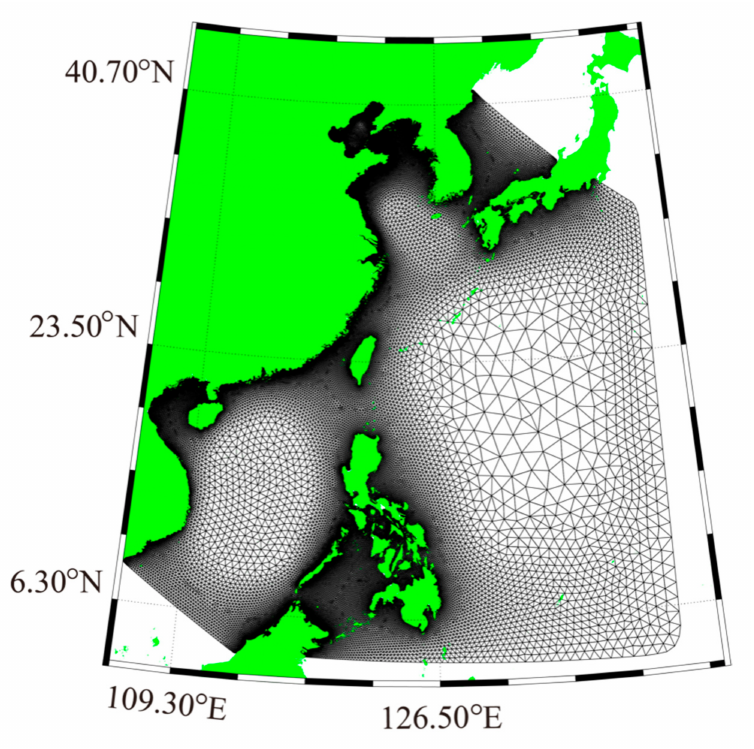
Figure 4. The unstructured grid of the simulated area for the SWAN model. Four locations (A–D) were selected for further